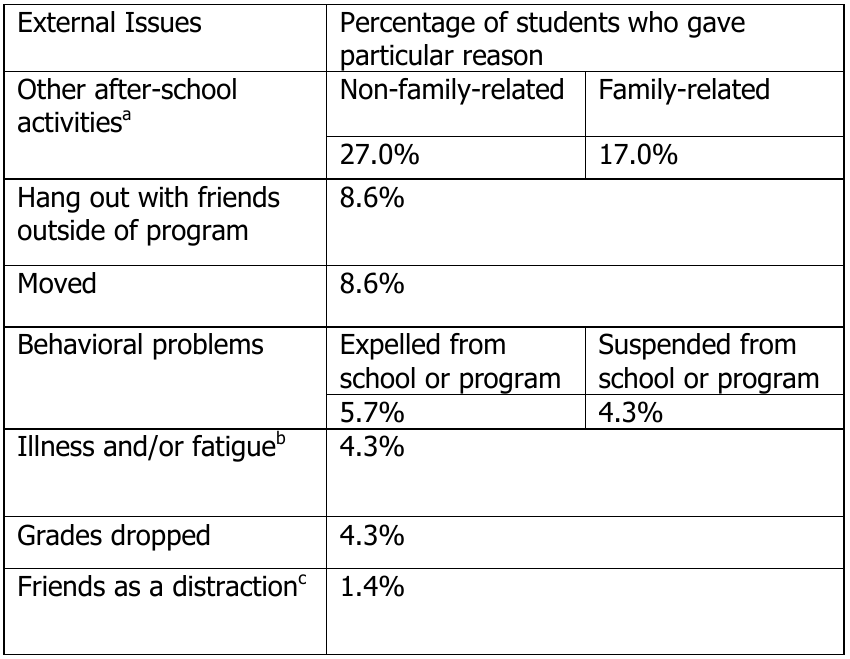
Reasons for Non-Attendance: External Issues,